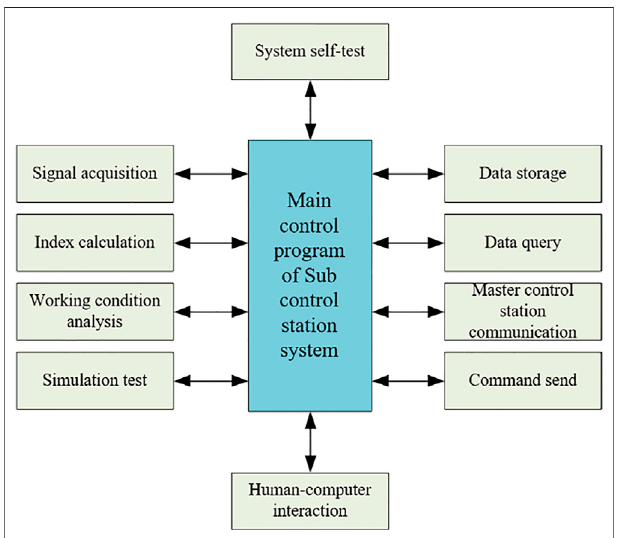
FIGURE 7 | Functional block diagram of the sub control station system.